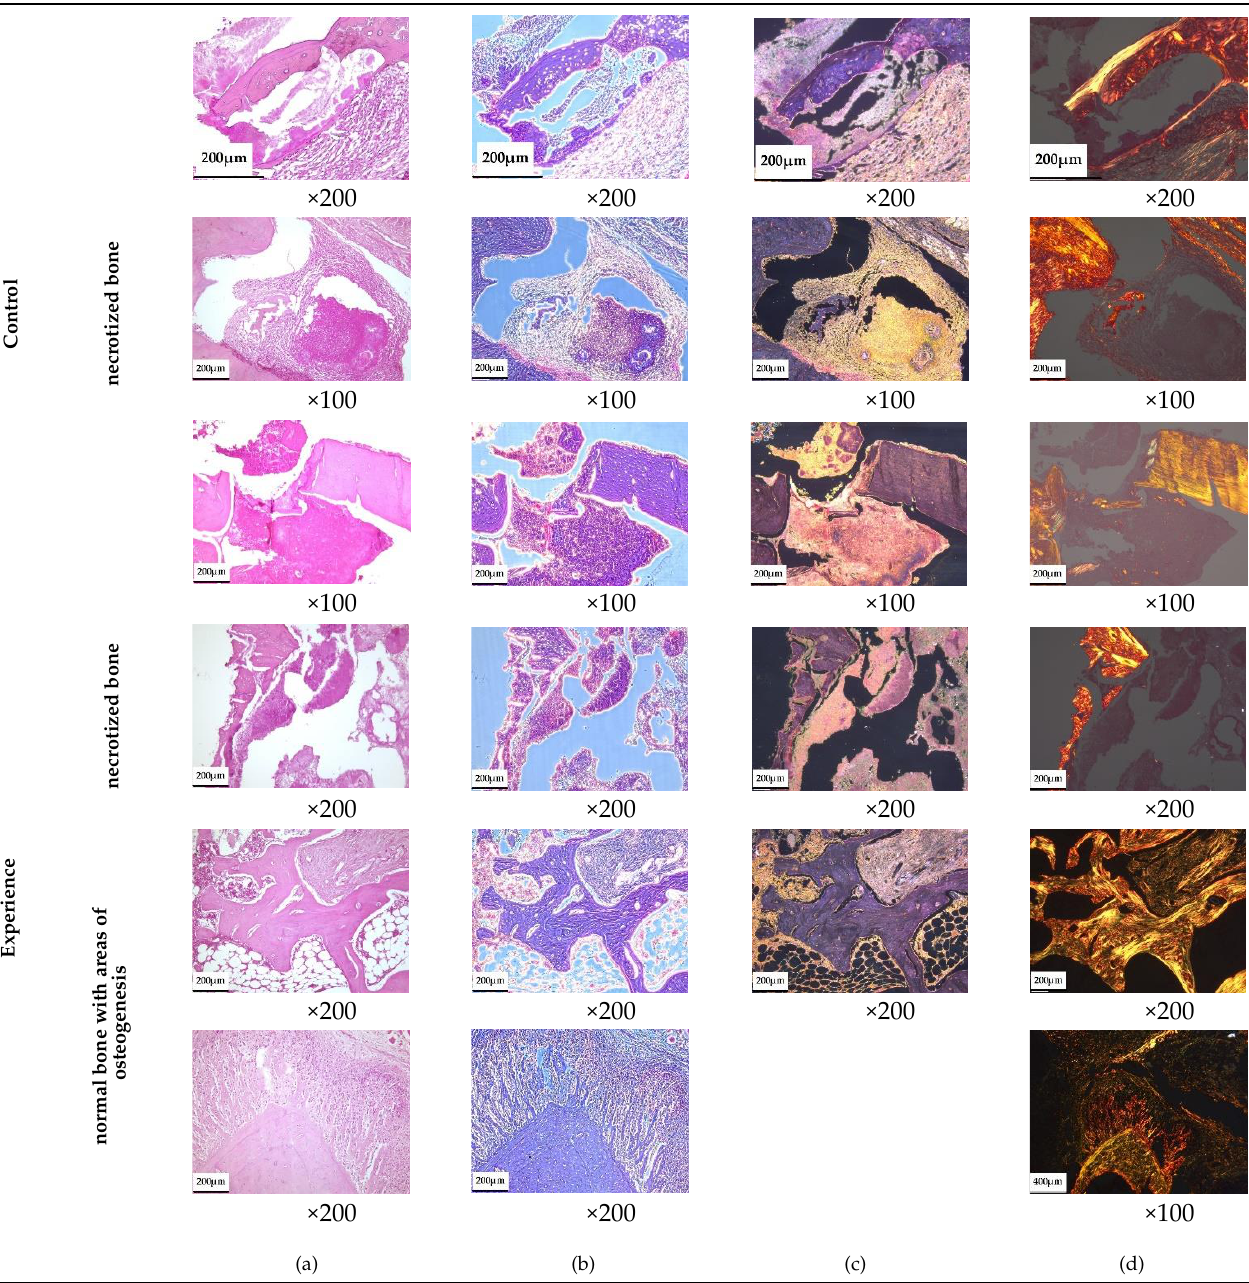
Table 5. Necrotized bone fragments: ( a ) Standard light microscopy; staining with hematoxylin–eosin. ( b ) Phase-contrast microscopy; staining with hematoxylin–eosin. ( c ) Dark-field microscopy; staining with hematoxylin–eosin. ( d ) Polarization microscopy; coloring with picrosirius red.